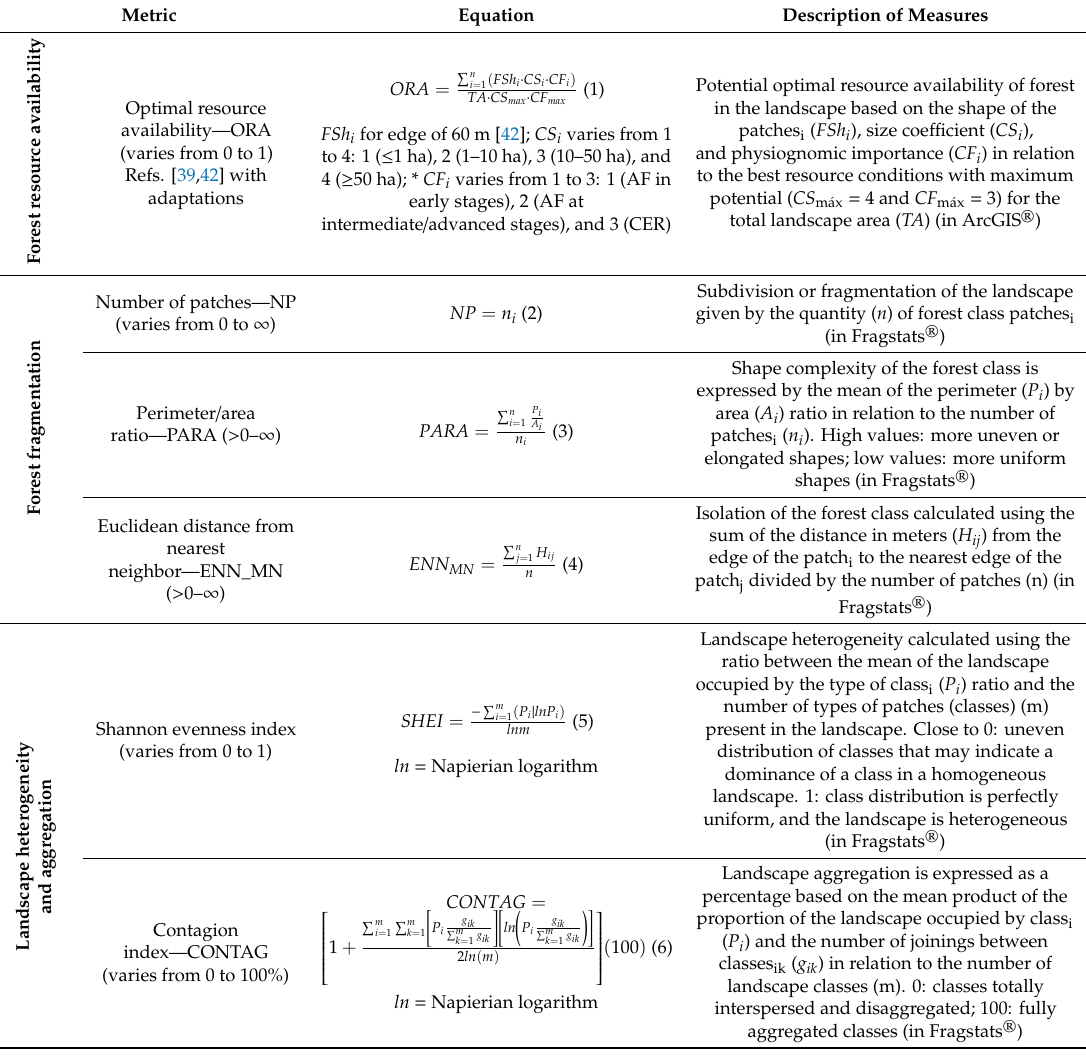
Table 1. Criteria for the structural evaluation and functional connectivity of the landscapes assessed in the Cerrado in the state of S ã o Paulo. Equation Description of